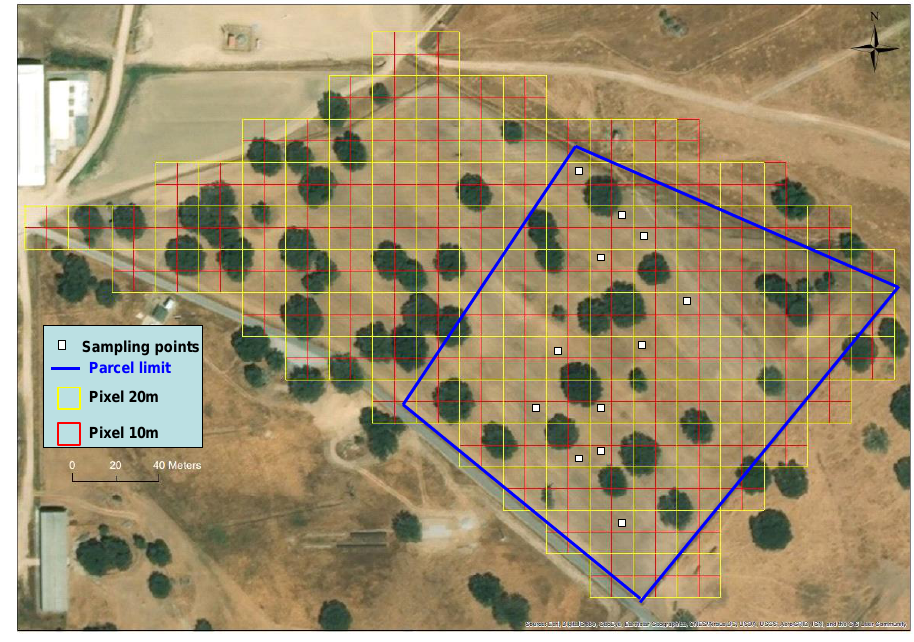
Figure 1. Experimental field located at the Mitra farm in the summer of 2016.